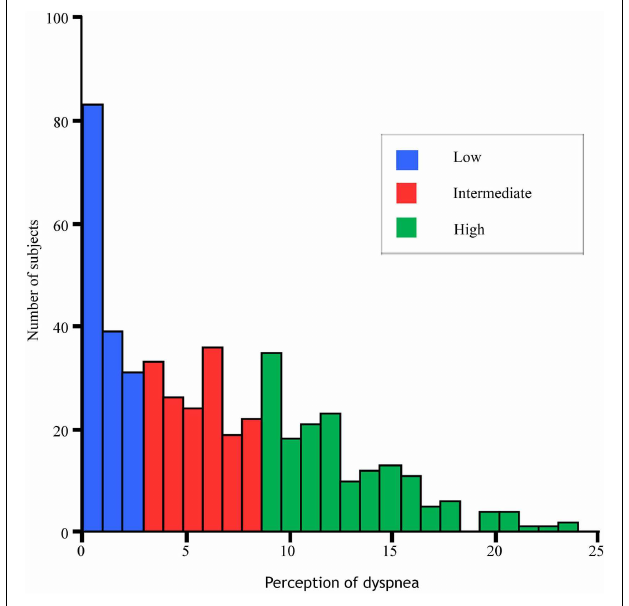
FIGURE 2 | Distributions of the perception of